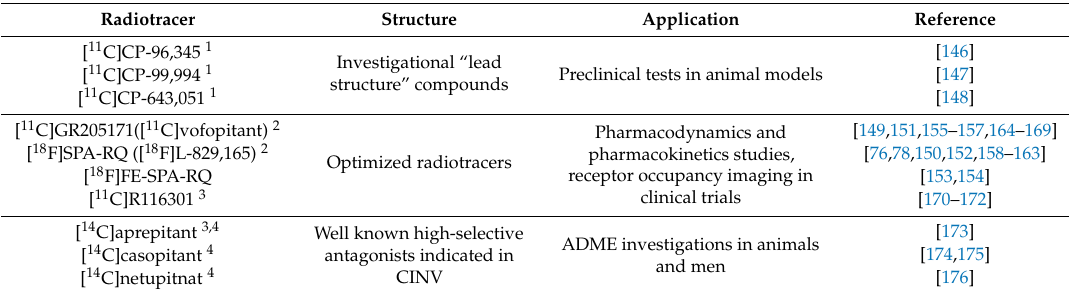
Table 6. List of selected radiolabelled NK1R